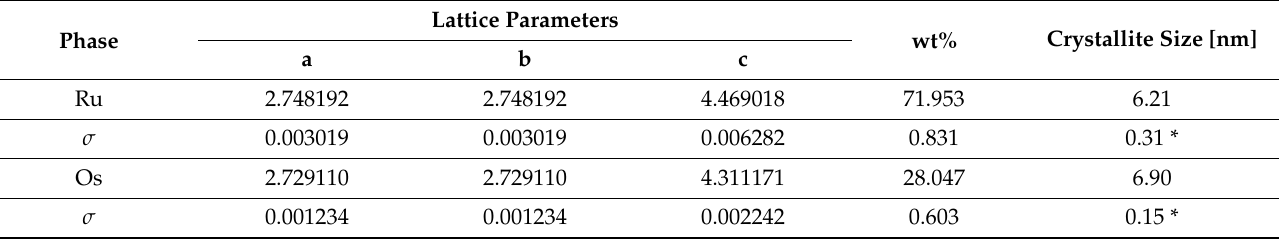
Figure 3. X-ray diffraction pattern of the OsRu electrocatalyst. In the plot, the black crosses represent the experimental data, the red line represents the calculated pattern, the blue line represents the background used for refinement, and the maroon line at the bottom represents the difference between the experimental and calculated pattern. The orange and green bars represent the positions of the Bragg peaks for Ru (P63/mmc) and Os (P63/mmc), respectively. In addition, for 2 θ = 9.59 ◦ , 15.12 ◦ , 19.20 ◦ , 28.97 ◦ , and 49.24 ◦ , the distances (d) calculated in each case are presented. The goodness-of-fit parameters ( χ 2 and Rwp) are also given. Table 3. Crystallographic data obtained by refining the OsRu diffraction pattern: lattice parameters, % weight of each phase and crystallite size obtained from Scherrer’s equation (with K = 1), with its respective standard deviations. The space group P63/mmc with occupancy factors of 1 was used for both